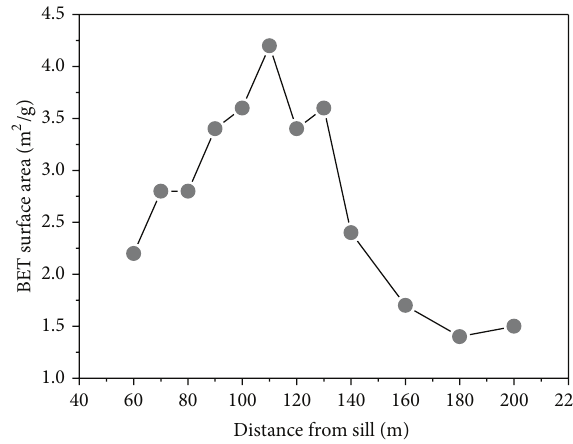
Figure 6: Relation between the BET surface area of coal and distance from sill.